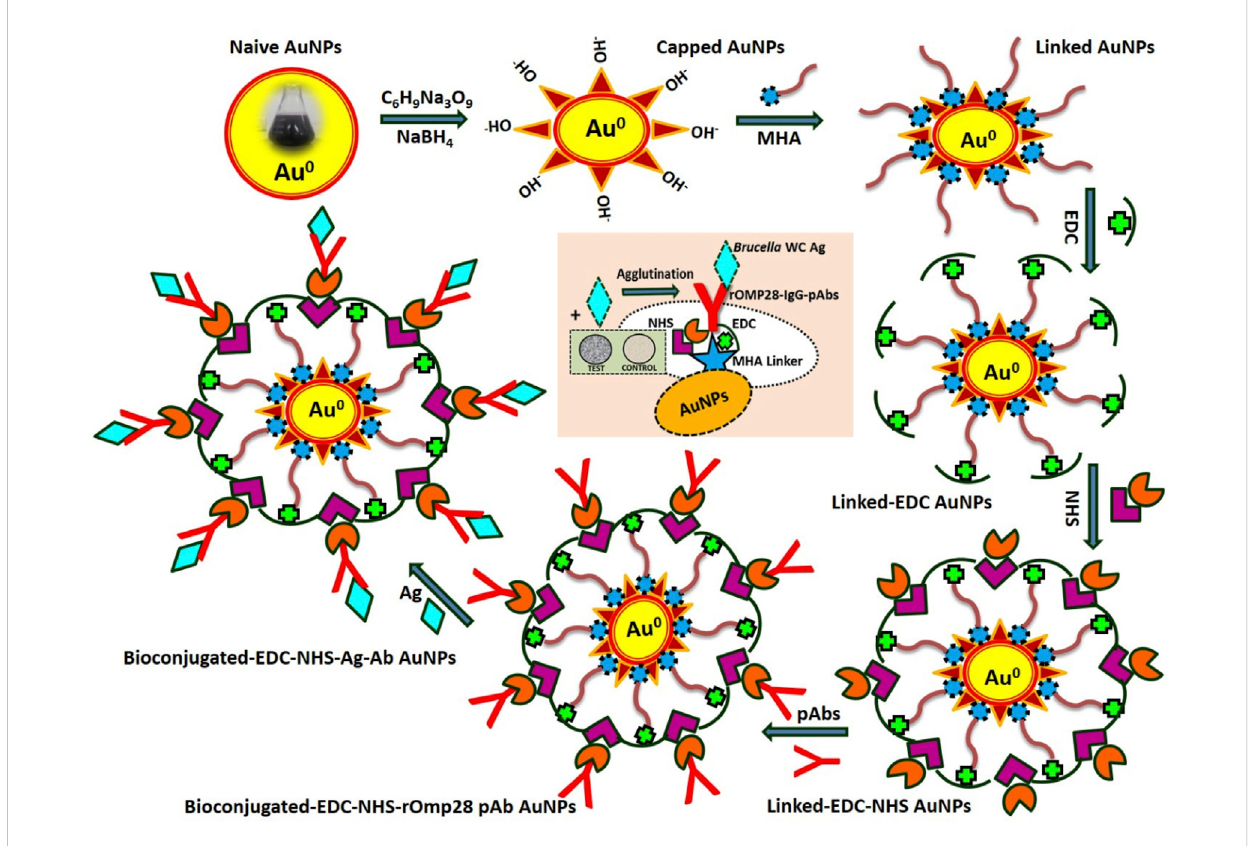
FIGURE 1 A complete scheme representing the methodology applied for development of agglutination assay using modi fi ed, functional, and bioconjugated AuNPs.